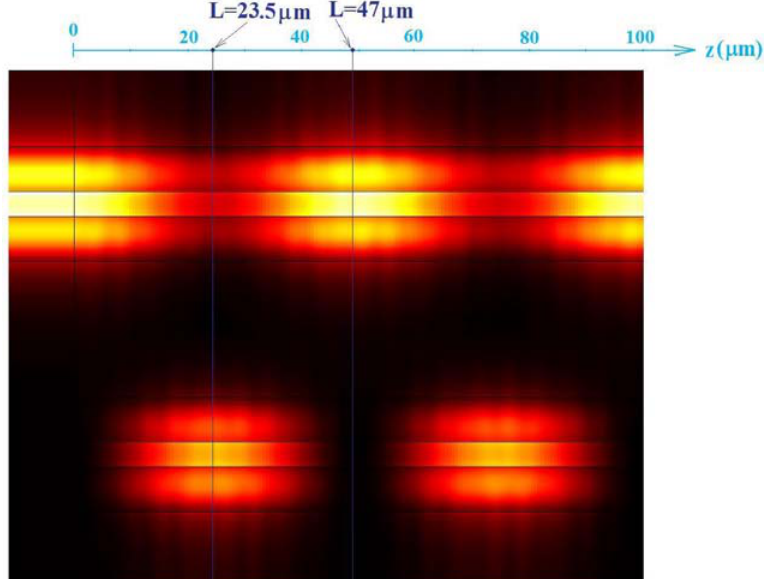
Figure 5 . Quasi-TE mode optical propagation in the designed asymmetrical directional coupler ( d = 1 μ m). Optical field intensity plot obtained by EME